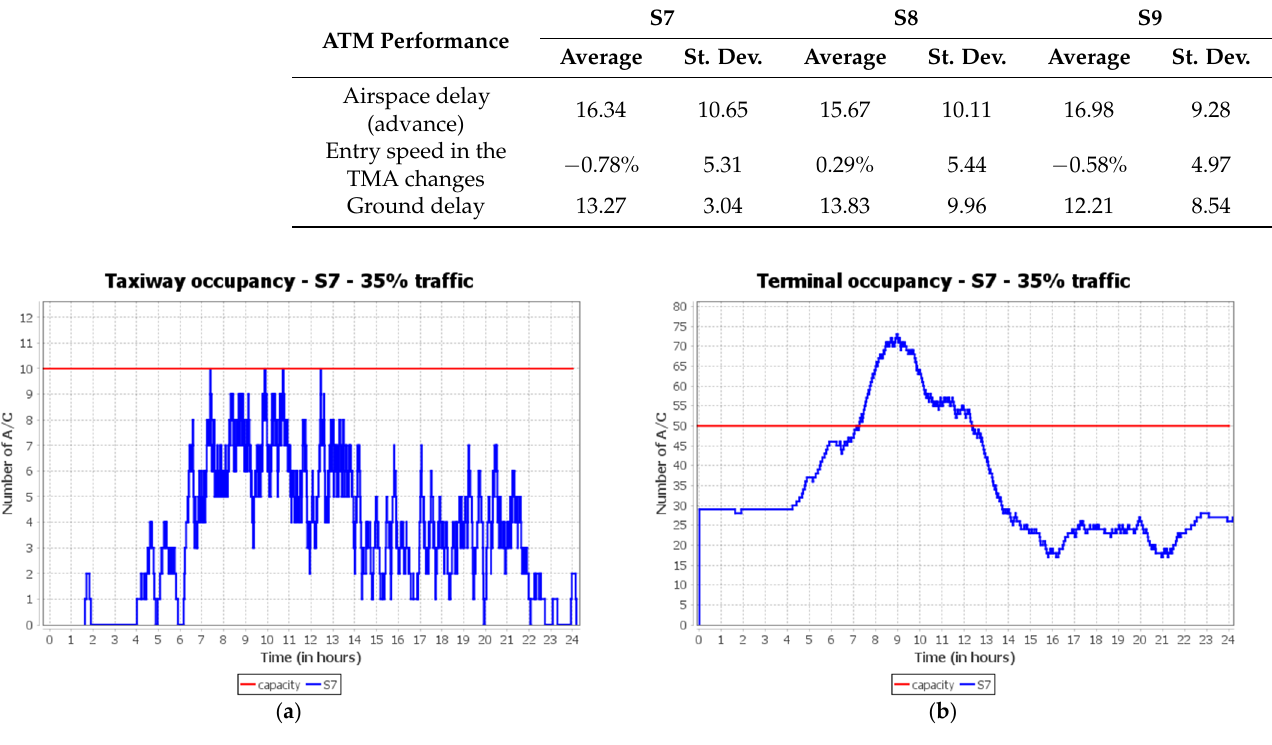
Figure 12. Taxiway ( a ) and terminal ( b ) occupancy scenario S7.